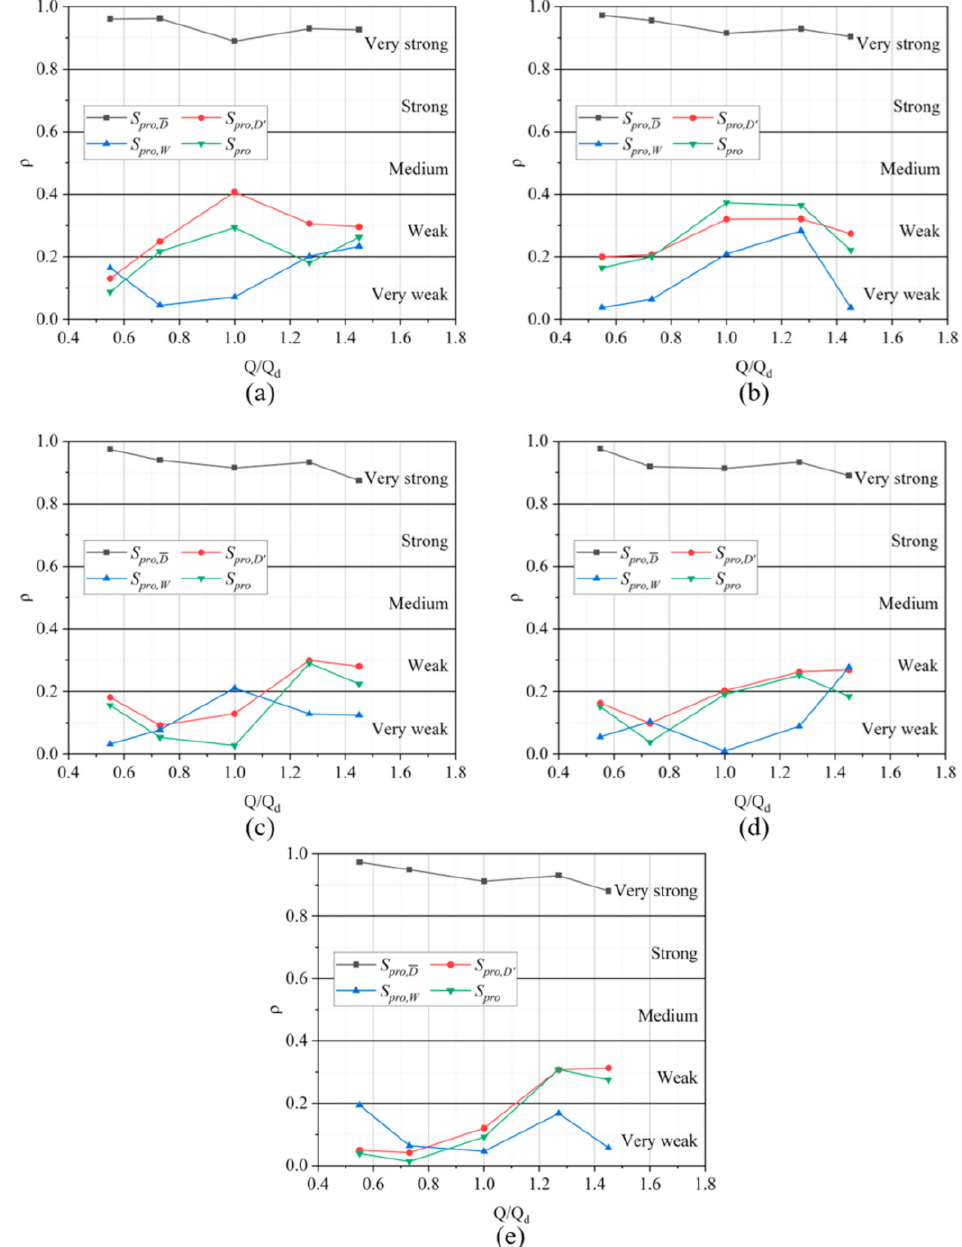
Figure 19. Correlation between dissipation effect and entropy production. ( a ) impeller1, ( b ) im‑ peller2, ( c ) impeller3, ( d ) impeller4, ( e )